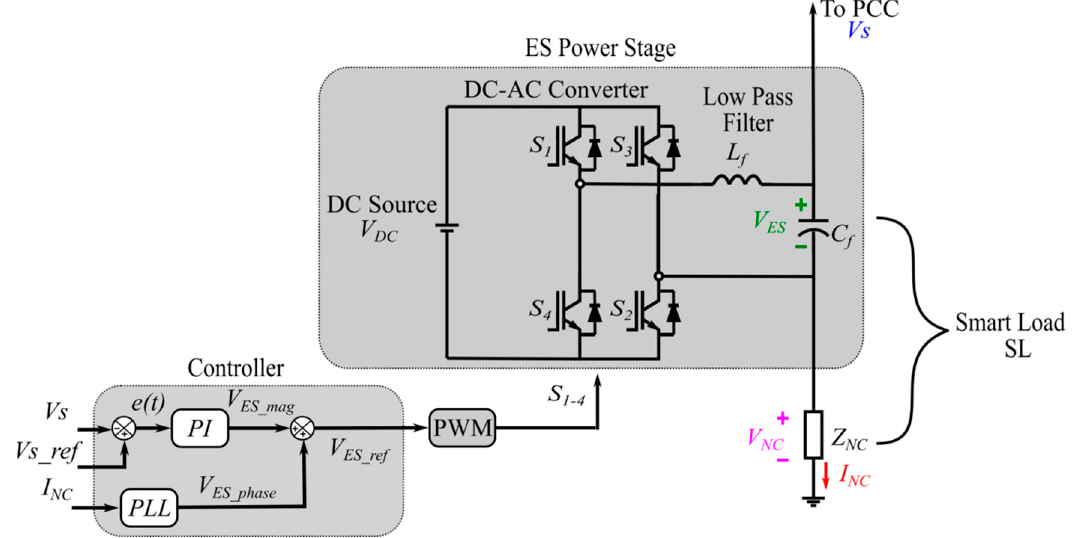
Figure 1. Electric spring dynamic model.